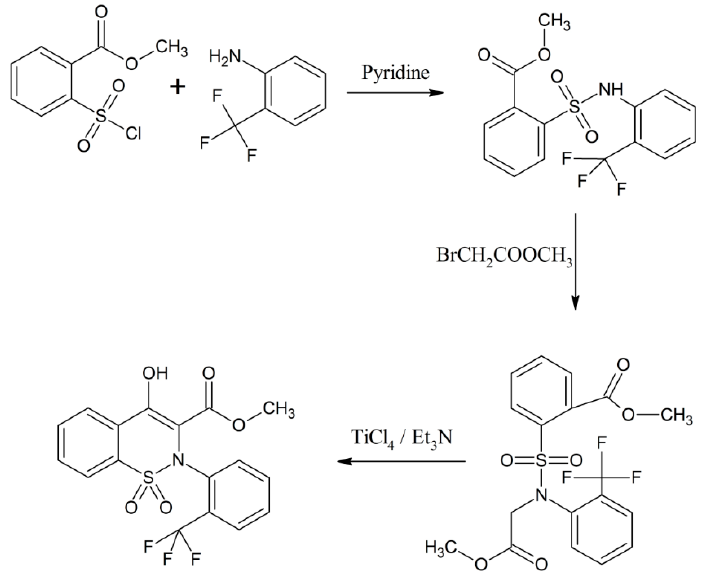
Scheme 7. Formation of 1,2-benzothiazine derivatives using methyl-2-(chlorosulfonyl) benzoate